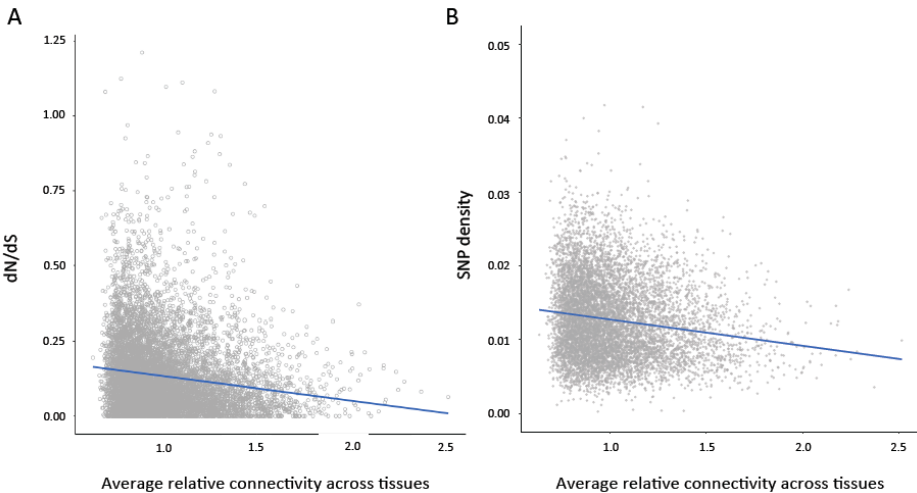
Figure 2. ( A ) Average connectivity across tissues is significantly negatively correlated with dN/dS ratio (Pairwise Spearman’s rank correlation rho = − 0.18, p < 0.0001; Partial Spearman rho = − 0.045, p < 0.0001). ( B ) Average connectivity across tissues is significantly negatively correlated with single nucleotide polymorphism (SNP) density (Pairwise Spearman’s rank correlation rho = − 0.16; p < 0.0001, Partial Spearman rho = − 0.09, p <